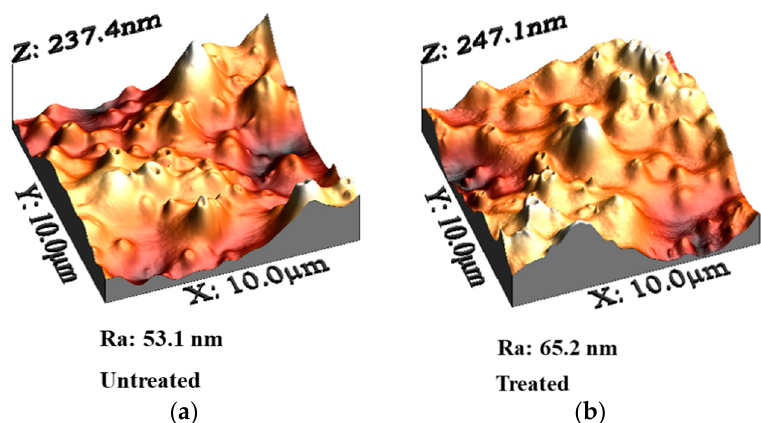
Figure 2. AFM micrographs of untreated ( a ) and atmospheric pressure plasma torch (APPT)-treated ( b ) acrylonitrile-butadiene-styrene (ABS).